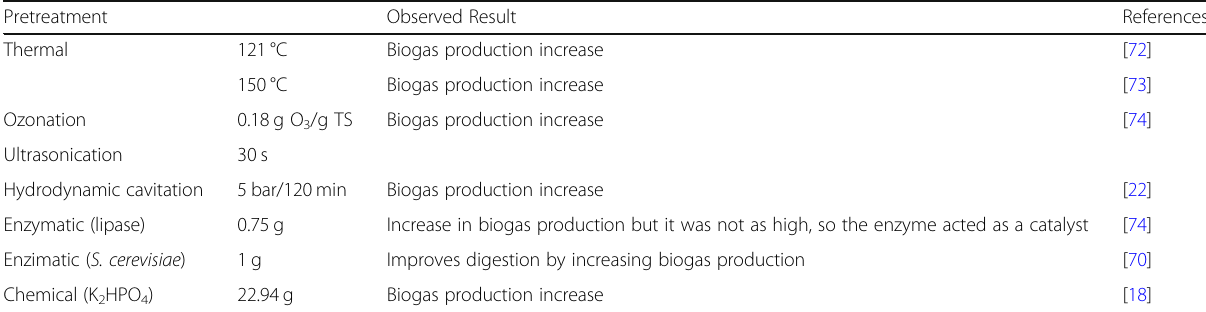
Table 5 Pretreatments to increase biogas production Pretreatment